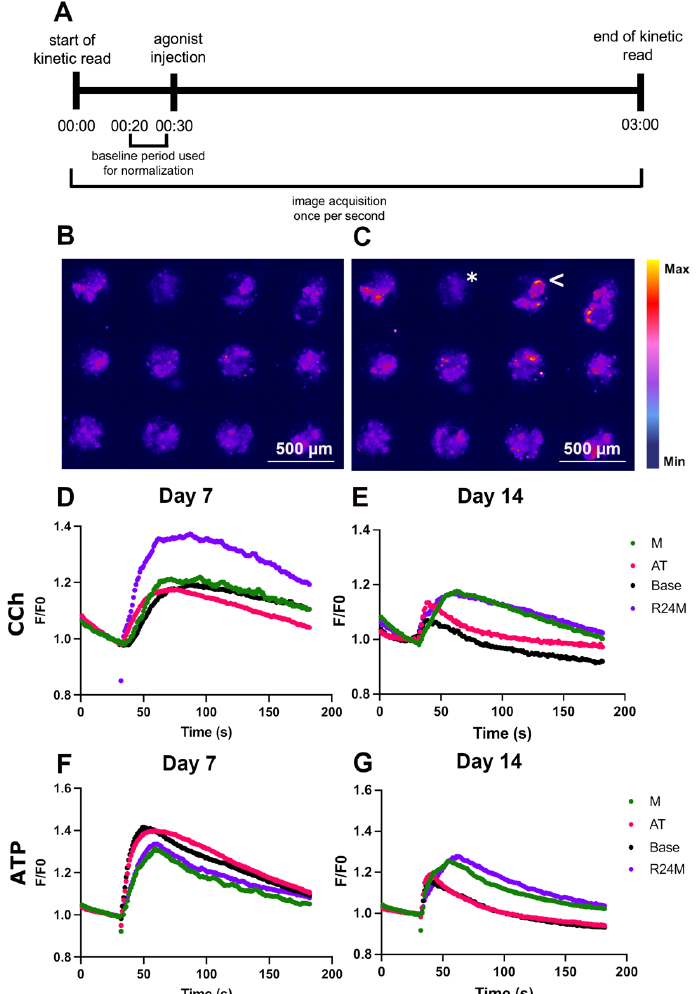
Figure 9. M and R24M media maintain calcium signaling. Timeline of the calcium signaling assay ( A ). Example images of the calcium signaling response before ( B ) and after ( C ) stimulation (example shown is day 7 AT stimulated with ATP). The asterisk (*) points to a non-responsive SGm and the less than sign (<) points to a responsive SGm. Time courses of the average response to CCh at day 7 ( D ) and day 14 ( E ) and ATP at day 7 ( F ) and day 14 ( G ). CCh (1 µM) or ATP (40 µM) were injected at 30 s. Data are represented as the average fluorescence intensity at each time point ( n = 3) normalized to the baseline period (average fluorescence of time 20–29 s).